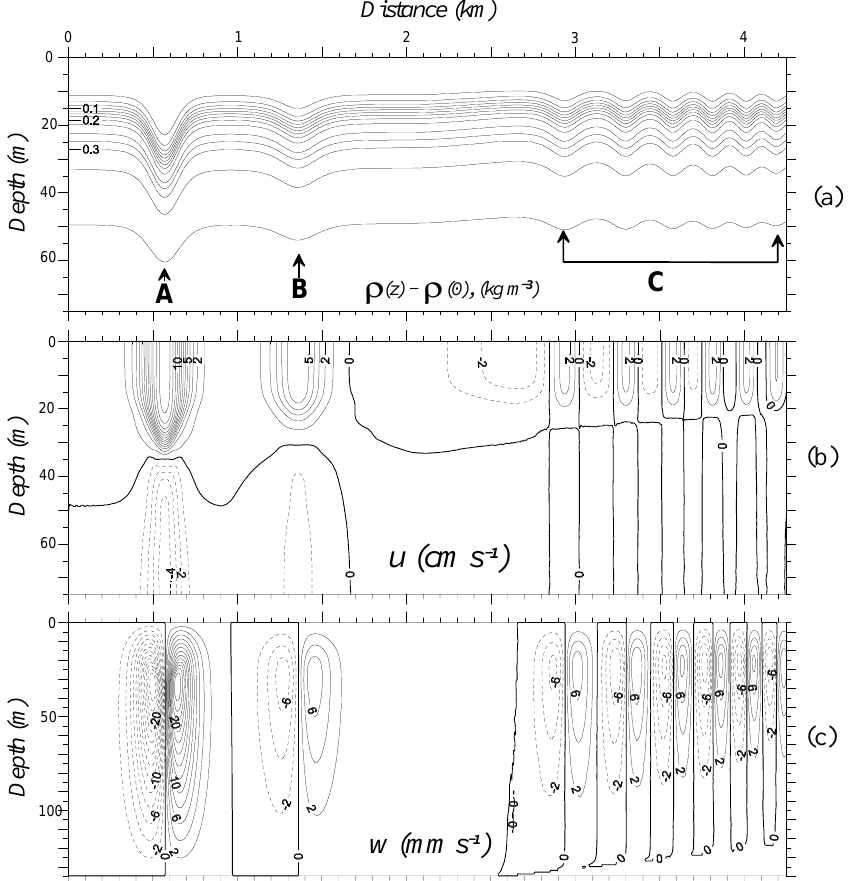
Fig. 6. The resulting wave field at t = 90 T after the penetration of a 15m SIW behind the underwater sill (profile 2 in Fig. 1). Panels (a) show the density anomaly relative to the free surface ( kg · m − 3 ), panels (b) show the fields of horizontal velocity u(cm · s − 1 ), (c) those of the vertical velocity w(mm · s − 1 ). Letters A, B and C indicate the same wave fragments as in Fig.